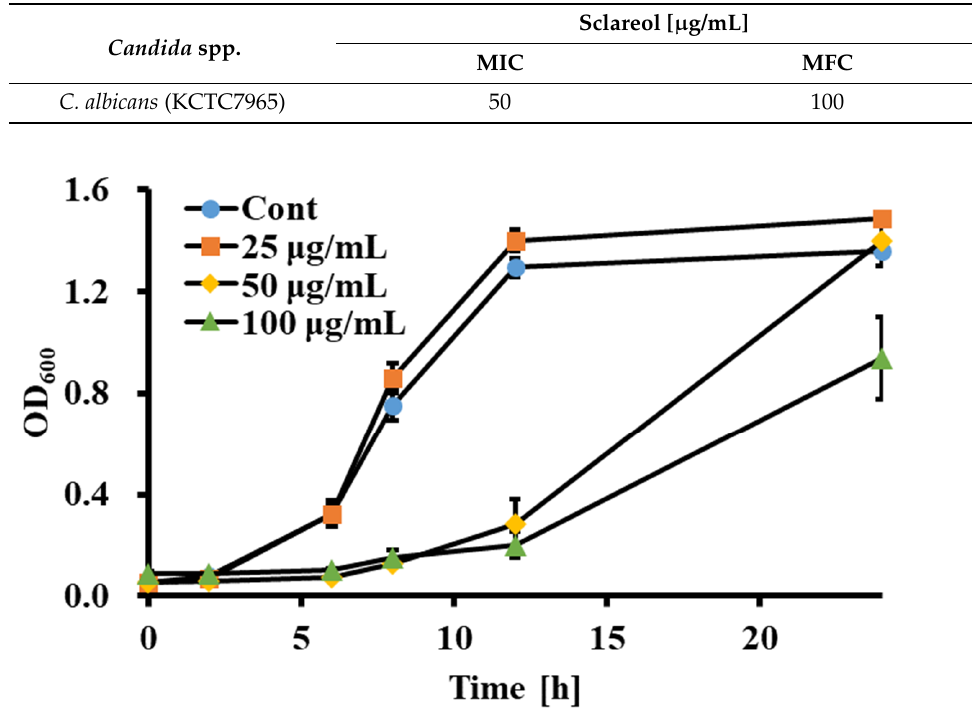
Table 3. Sclareol showed fungistatic activity against C. albicans . Candida spp.